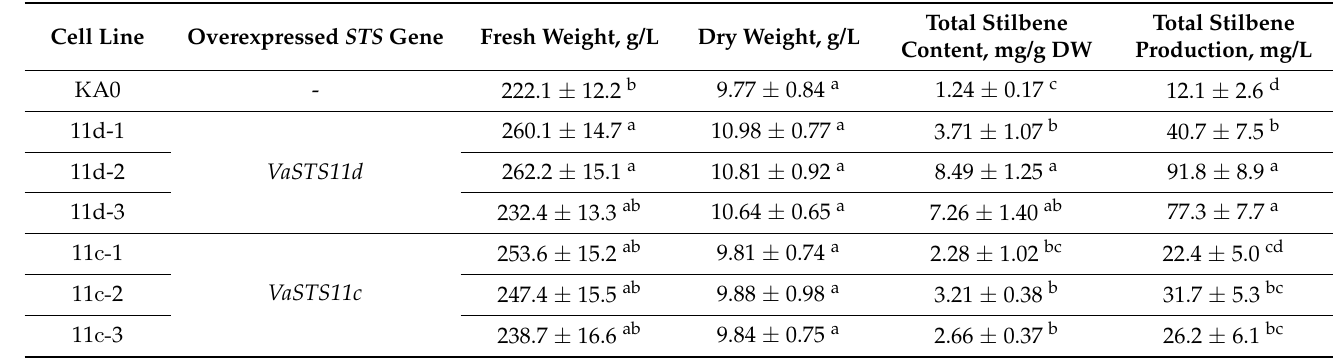
Table 2. Biomass and stilbene accumulation in the cell lines of Vitis amurensis overexpressing the VaSTS11c or VaSTS11d gene transcripts. Means followed by the same letter were not different using Student’s t test, where p < 0.05 was considered to be statistically